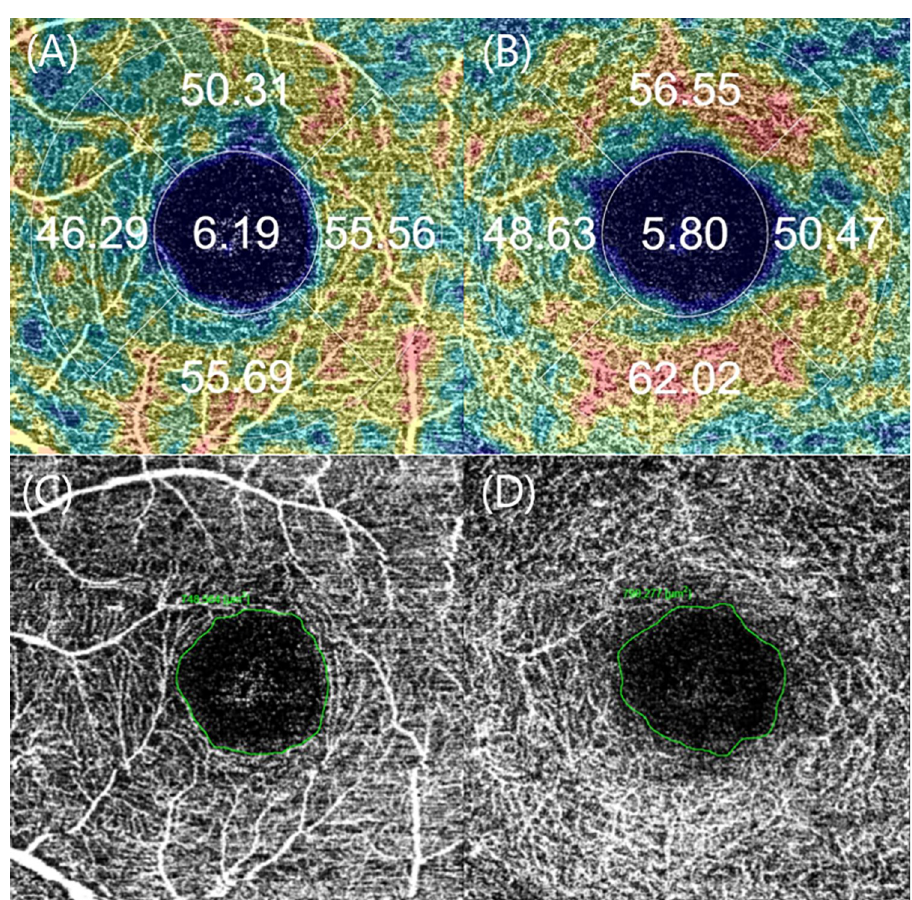
Fig 1. Macular en face images of an optical coherence tomographic angiography scan. The vascular densities of superficial (A) and deep (B) capillary complexes are automatically calculated. The foveal avascular zone (FAZ) borderline is analyzed manually and the FAZ areas of the superficial (C) and deep (D) capillary complexes are calculated automatically using the area measurement tool in IMAGEnet 6. map of the macula from the raster scan. In OCT-A, the 3.0 × 3.0 mm macular en face images were divided into superficial capillary plexus (SCP) and deep capillary plexus (DCP) automati- cally. Vessel density (VD), defined as the ratio of the area of the vessel and microvasculature to the total area, was automatically measured from the SCP and DCP images of IMAGEnet 6 (version 1.22, Topcon, Tokyo, Japan). Among the ETDRS subfields, the central area was defined as a centered 1.0-mm-diameter circle; the annular area that remained after subtraction of the central area from the 3.0-mm-diameter circle was defined as the paracentral area. Para- central areas were divided into four areas: temporal, nasal, superior, and inferior. The superfi- cial and deep foveal avascular zone (FAZ) borderline was analyzed by a retinal specialist using IMAGEnet 6 (Fig 1).